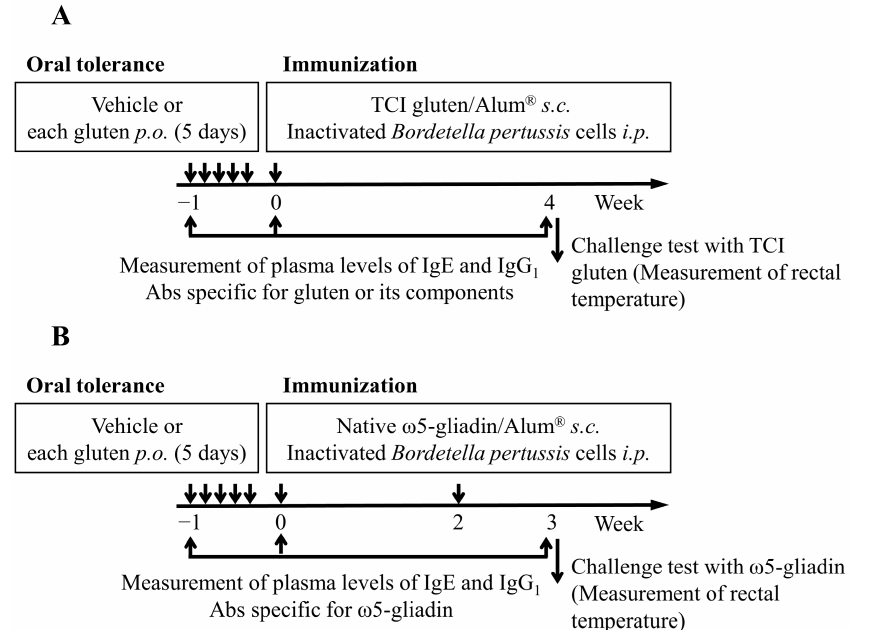
Figure 1. The immunization and induction of oral tolerance to gluten and its components (schematic). BN rats were orally administered with vehicle alone (50% ethanol) or 10 mg of each type of gluten daily for 5 days for OT induction. At 2 days after the final oral administration (week 0), rats were administered subcutaneously once with TCI gluten for immunization with gluten ( A ). For immu- nization with ω 5-gliadin, rats were administered subcutaneously with ω 5-gliadin at weeks 0 and 2 ( B ). Blood was collected to measure the plasma levels of IgE and IgG 1 Abs specific for gluten or its components at weeks − 1, 0, and 3 (for ω 5-gliadin study) or 4 (for gluten study). Rectal temperatures were measured after challenge with TCI gluten or ω 5-gliadin at week 3 or 4 intravenously. p.o. , per os (oral administration); s.c. , subcutaneous administration; i.p. , intraperitoneal